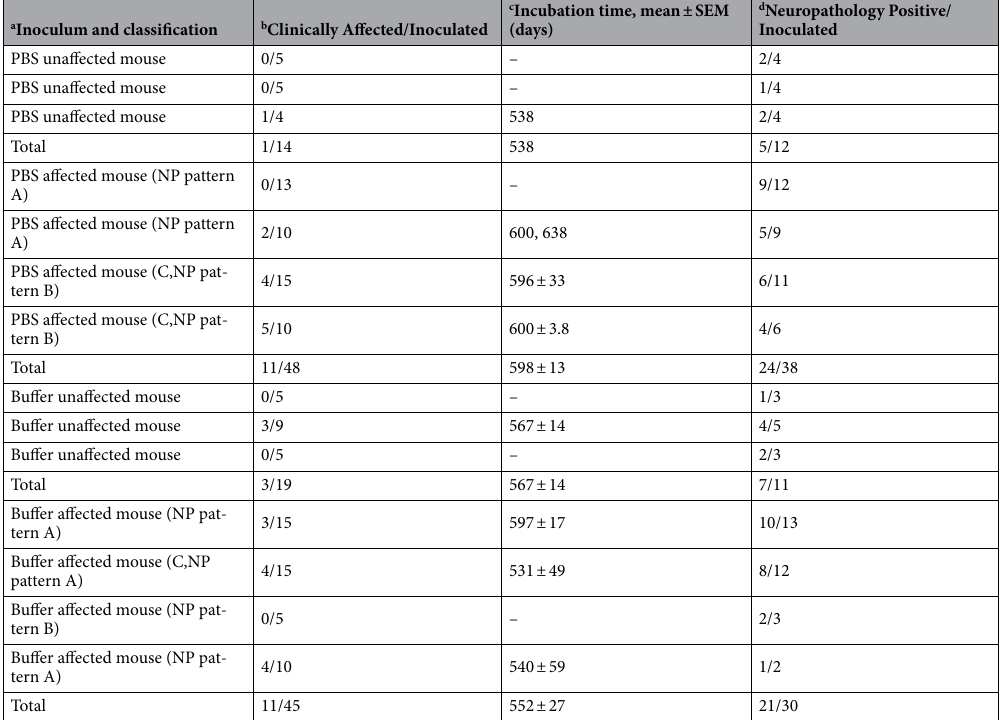
Table 2. Incidence of clinical signs and neuropathological changes following second passage into further Tg20 mice. a Inocula comprised 1% w/v brain homogenate from Tg20 mice originally challenged intracerebrally with D-PBS or Buffer (Table 1). Unaffected mice showed no clinical signs consistent with prion disease and no neuropathological changes whereas affected mice were either positive for clinical signs consistent with prion disease (C) or positive for neuropathological changes (NP) or both (C, NP). Inoculated mice were observed daily over their lifespan and culled if showing signs of clinical prion disease, distress caused by inter-current illness, or senescence or at termination of the experiment. b Clinical disease was defined by the criteria described in Methods. c Survival times are reported for clinically affected mice in days post inoculation; where n ≥ 3 the mean ± SEM is reported otherwise individual incubation times are given. d Positive neuropathology comprises spongiform change, either alone, or in combination with the presence of abnormal PrP detected by immunohistochemistry.